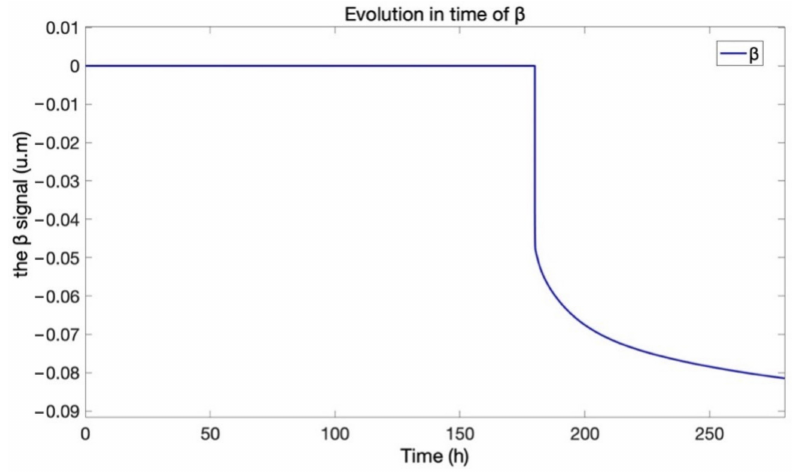
Figure 21. Evolution in time of control effort ( ∆ β ) if the variation of β = 0.91 to β = 0.82 at t = 180 ( h ) occurs.